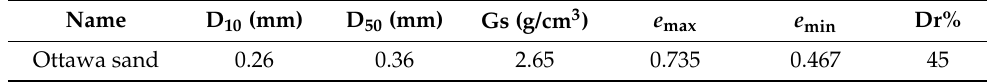
Table 1. Properties of sand used in this